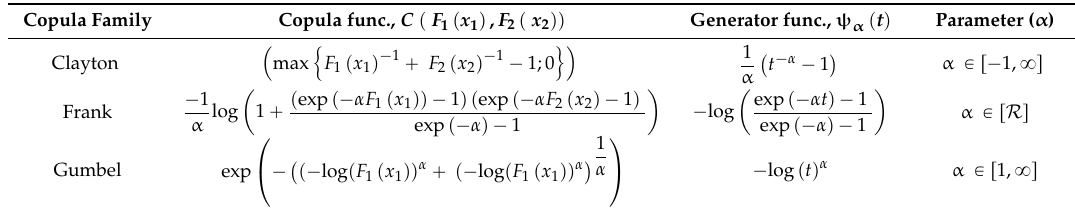
Table 2. Bivariate Archimedean copula family: C is the copula function, t denotes the drought event, α is the copula parameter, and F 1 and F 2 denote cumulative distribution function of each variable [79]. Copula